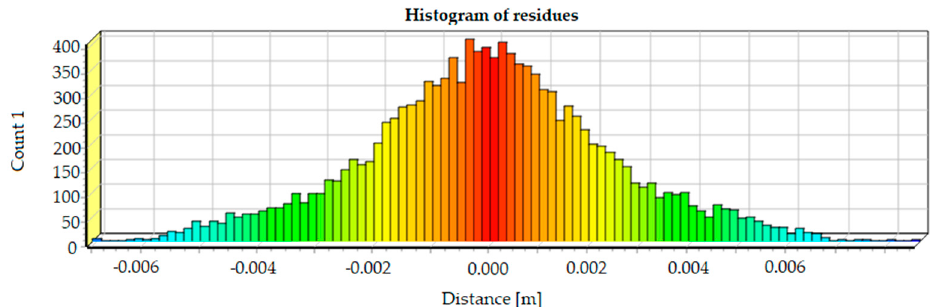
Figure 6. Histogram of residues.